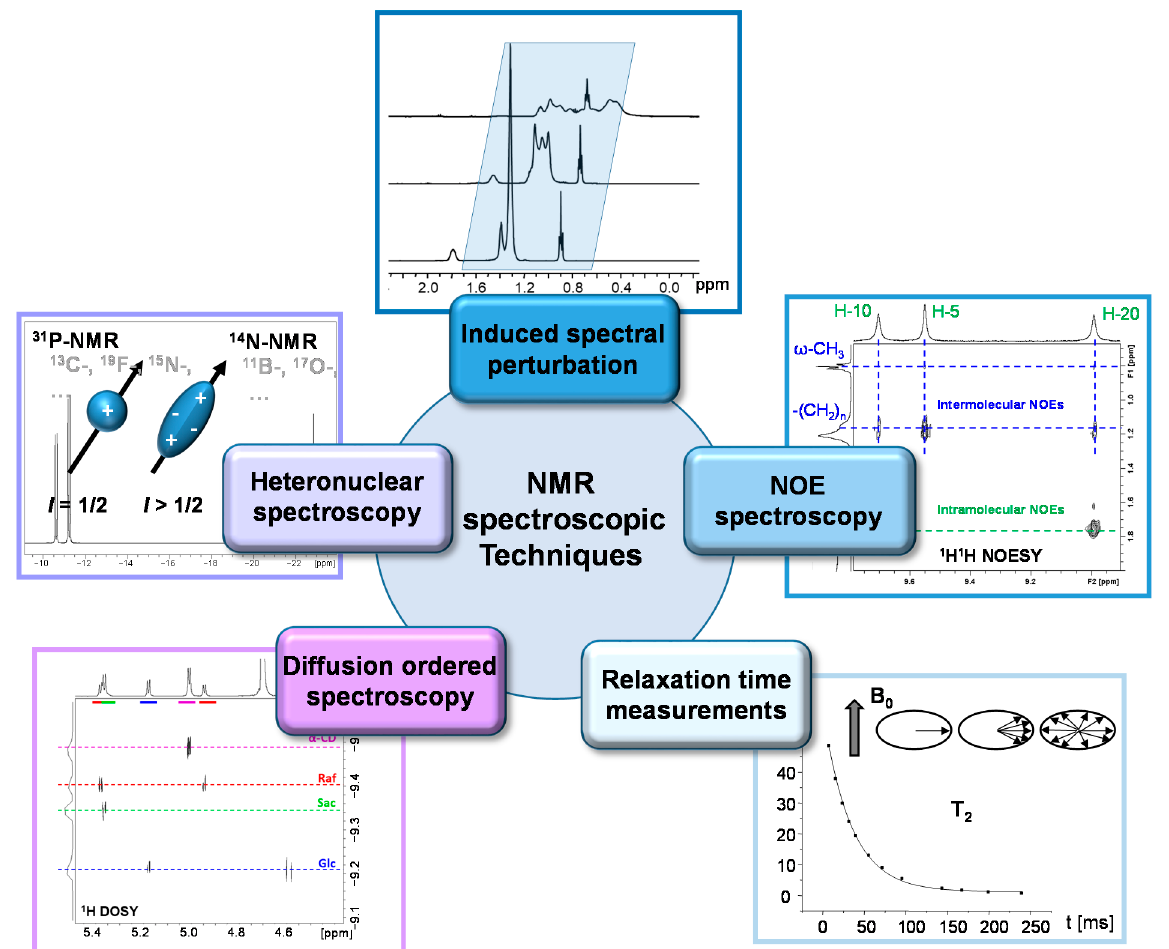
Figure 4. Overview of selected NMR techniques to study porphyrin–macromolecule interactions.